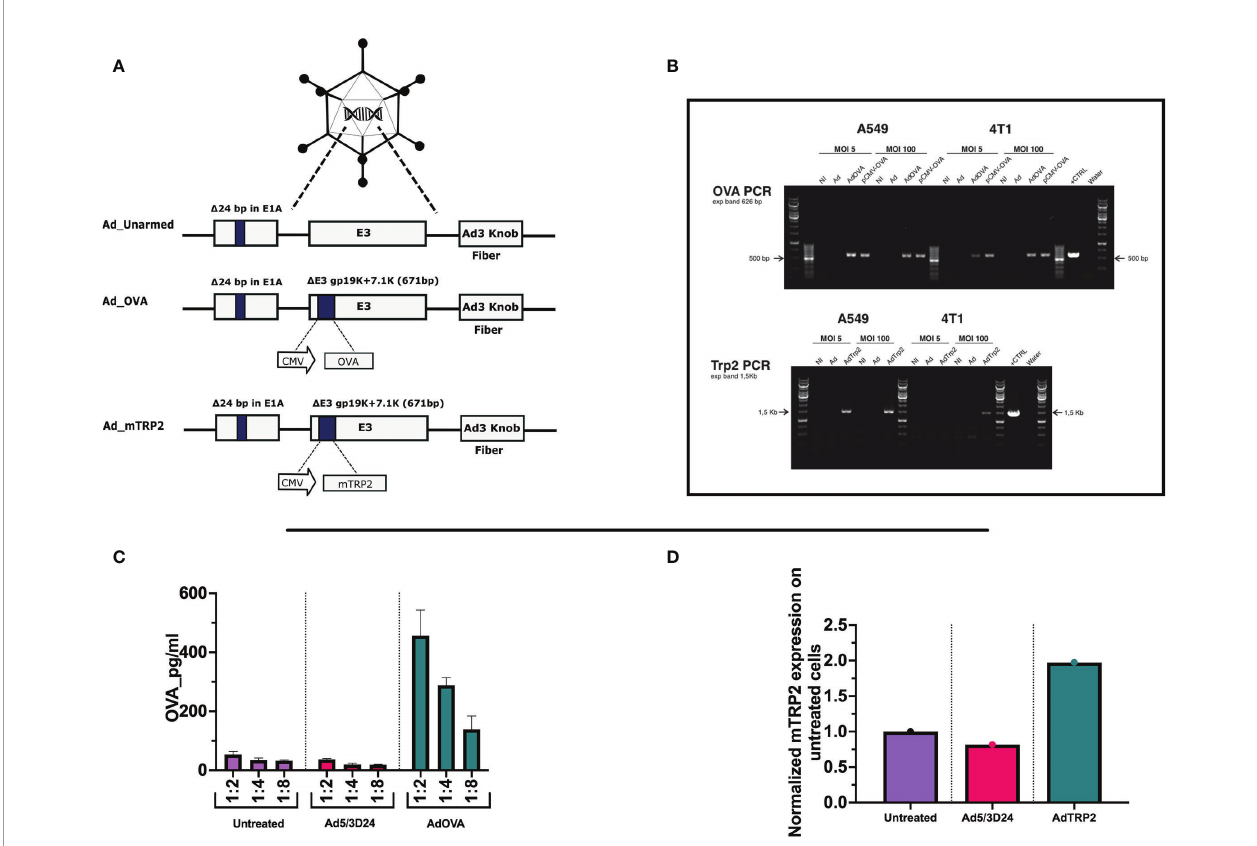
FIGURE 1 | Generation and characterization of AdOVA and AdTRP2 (A) Schematic representation of oncolytic adenovirus delta 24 (Ad5/3-D24) constructs with modi fi cations in E1, E3, and fi ber region. Both unarmed (Ad_unarmed) and armed (Ad_OVA and Ad_mTRP2) bear a deletion of 24bp in the E1A gene. Additionally, AdOVA (Ad_OVA) and AdTRP2 (Ad_mTRP2) contains an expression cassette under CMV promoter in E3 region. (B) Reverse-transcribed PCR reaction with speci fi c primers for OVA and mTRP2 on cDNA derived from A549 and 4T1 infected with 5 and 100 MOI. (C, D) A549 cells were infected with 10MOI and the cell lysate was collected at 48h and OVA and TRP2 levels were checked by ELISA and the data are depicted as bar